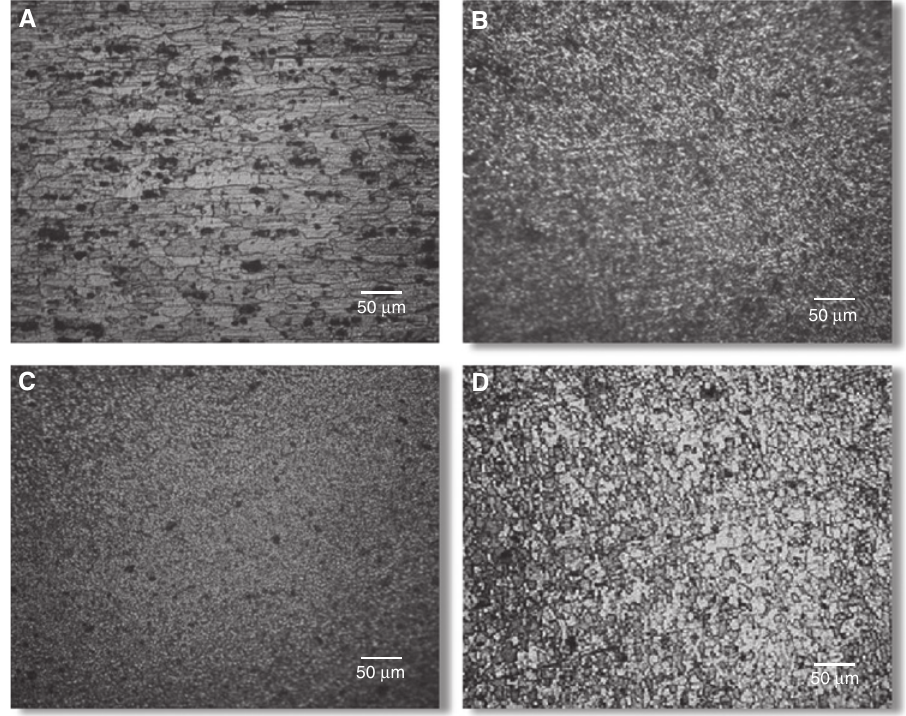
Figure 8: Optical micrograph of stir zone of (A) PM, (B) AW, (C) AA, (D) STA